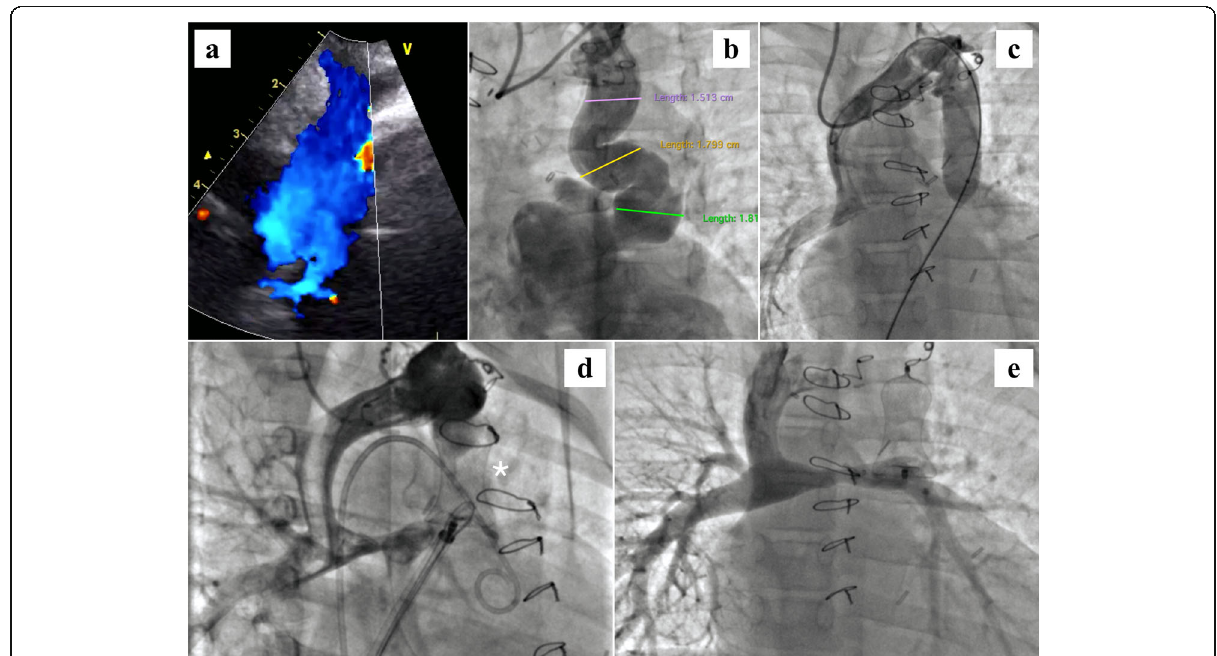
Fig. 2 Occlusion of large venous collateral: a Large venous channel draining toward the heart in the region of a normal left superior vena cava. b Innominate vein injection shows the tortuous venous communication with multiple bends (measurements given at different segments), ultimately draining into the roof of left atrium. c Innominate angiogram with a 18 × 40 mm Tyshak II balloon completely occluding the venous channel shows normal drainage across the Glenn circuit. d Twenty-four millimeter Lifetech cera vascular plug (white asterix) deployed at the proximal end of the venous channel from femoral route. Innominate injection shows complete occlusion with normal Glenn flow. e Superior vena cava angiogram after release of the plug showing good flow into both branch pulmonary